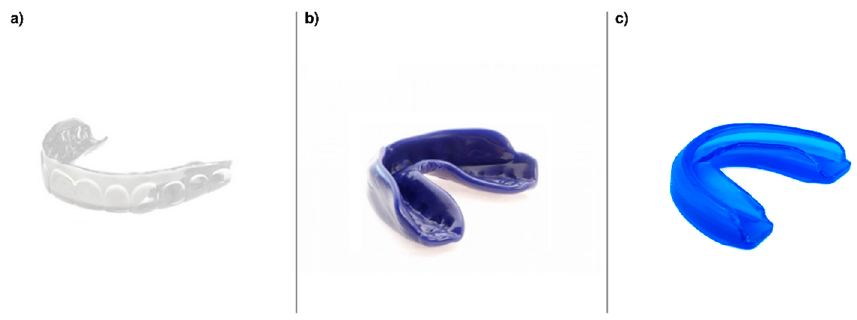
Figure 2. Types of mouthguards described in the systematic review: ( a ) Custom-made MG, ( b ) Self- adapted MG, ( c ) Standard MG.